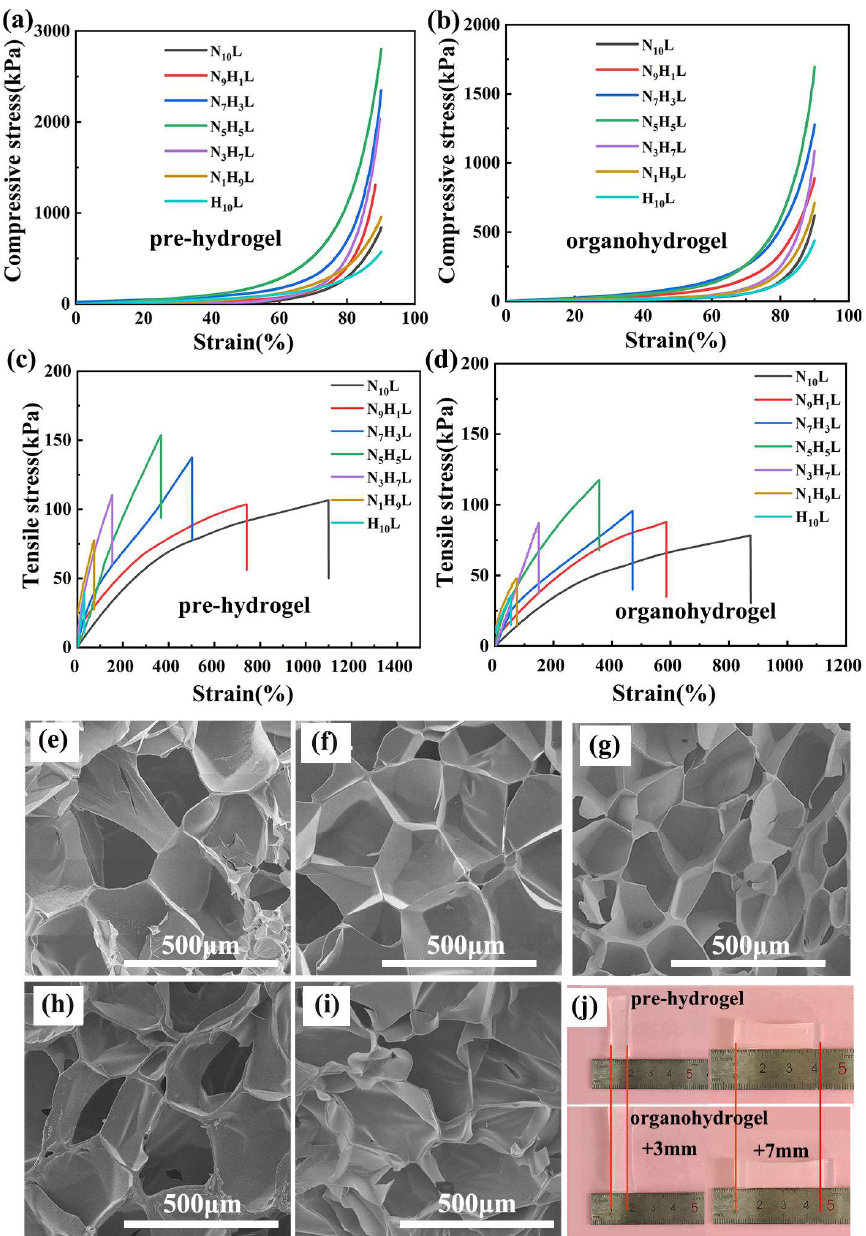
Figure 3. ( a , c ) Compression and tensile stress-strain diagram of pre-hydrogels; ( b , d ) Compression and tensile stress-strain diagram of NC organohydrogels; SEM of the pre-hydrogels with different molar ratios of NIPAM/HEA: ( e ) 10:0, ( f ) 7:3, ( g ) 5:5, ( h ) 3:7, ( i ) 0:10, respectively; ( j ) Comparison of hydrogels before and after being immersed in EG/water mixed solution.